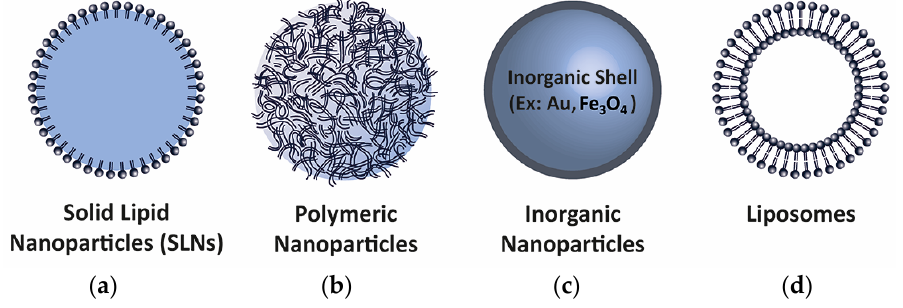
Figure 5. Schematic representation of different types of nanoparticles used to deliver biomolecules. ( a ) Solid lipid nanoparticles (SLNs); ( b ) Polymeric nanoparticles; ( c ) Inorganic core-shell nanoparticles (Au: gold, Fe 3 O 4 : iron oxide); ( d ) Lipid bilayer-based